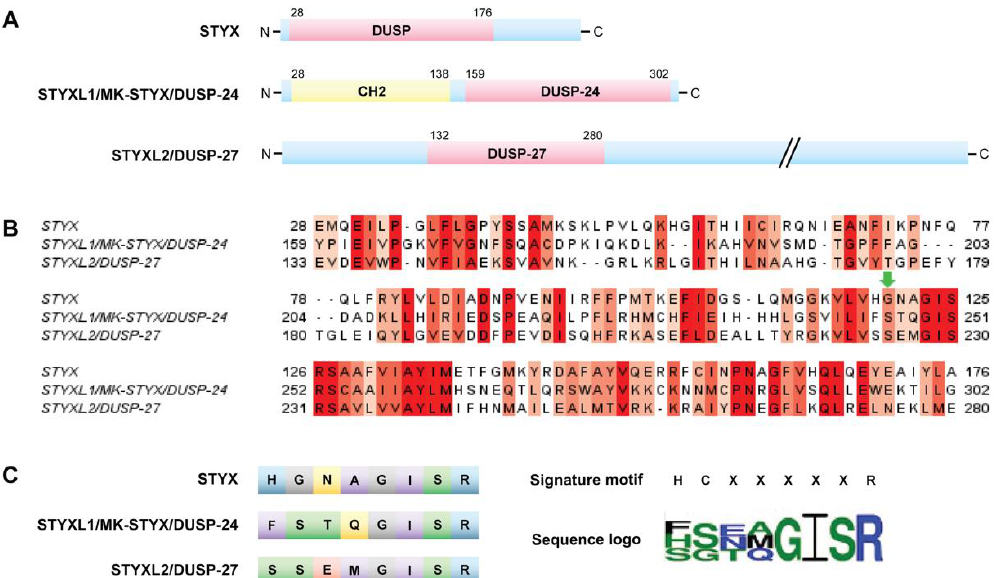
Figure 5. STYX pseudophosphatases: ( A ) Structure of STYX pseudophosphatases. STYX has an N-terminal DUSP domain. MK-STYX features an N-terminal CH2 domain and a C-terminal DUSP domain. STYXL2 contains an N-terminal DUSP domain. ( B ) Sequence alignment of the phosphatase domains of the STYX pseudophosphatases (Clustal Omega 1.2.4). Conserved residues are shown in red, where darker red indicates higher conservation (Jalview 2.11.14 with a threshold of >5.5). The green arrow indicates where the essential active-site cysteine residue would be located in a catalytically active PTP (HCX 5 R). ( C ) The left-hand side of the panel compares the active site sequences of the STYX pseudophosphatases. Amino acid color indicates chemical property. Polar amino acids are shown in green, neutral in yellow, basic in blue, acidic in red, hydrophobic in purple, and glycine in grey. The right-hand side of the panel shows the sequence of the consensus active signature motif of PTPs compared to the sequence logo of the three STYX pseudophosphatases. The sequence logo was built by WebLogo 3.7.4 with a 2.0-bit scale.